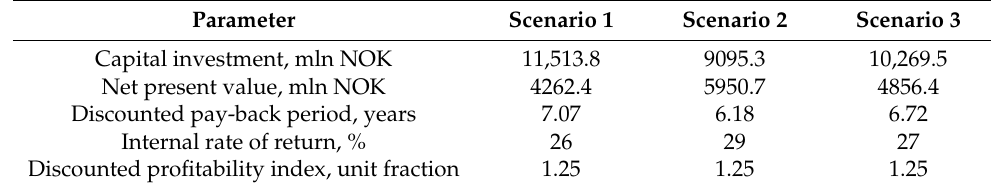
Table 14. Economic parameters of possible arrangement scenarios for the Avaldsnes section.